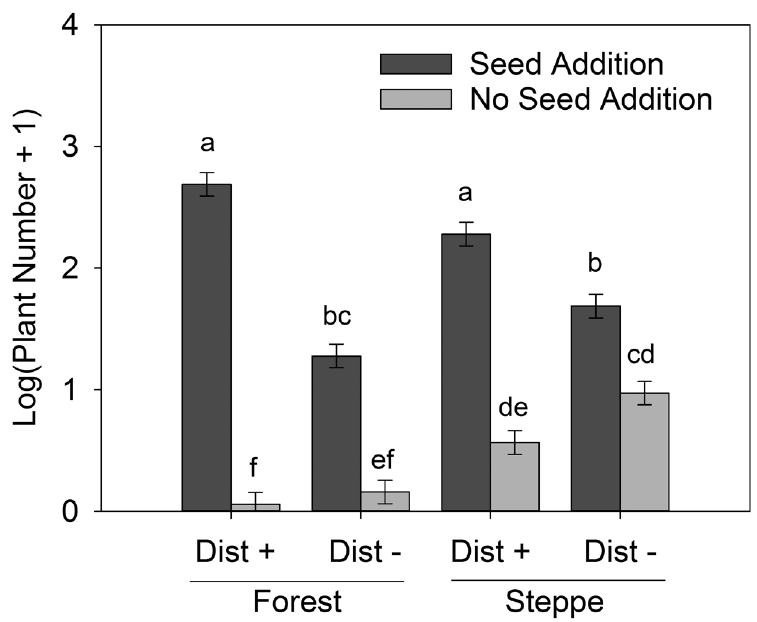
Figure 1. Effect of habitat (Forest versus Steppe), disturbance (Disturbed [“Dist+”] versus Undisturbed [“Dist-”]), and seed addition (Seed Addition versus No Seed Addition) on the average number of total plants in each plot in July 2012. All plant counts are log(x+1) transformed and responses are reported as least square means estimates ± SE. Post hoc multiple pairwise comparisons were conducted with the Tukey-Kramer method; different lowercase letters indicate significant differences at a Type I error = Table 2. General linear mixed model analysis describing the influence of habitat, disturbance, plant introduction class, and the interaction of these fixed factors on the square root-transformed individual biomass of plants harvested (July 2012) from plots established in Pacific Northwest steppe and forest com- munities. Significant differences at Type I Error = 0.05 indicated in bold; marginally significant differences at Type I Error = 0.10 are indicated in italics.